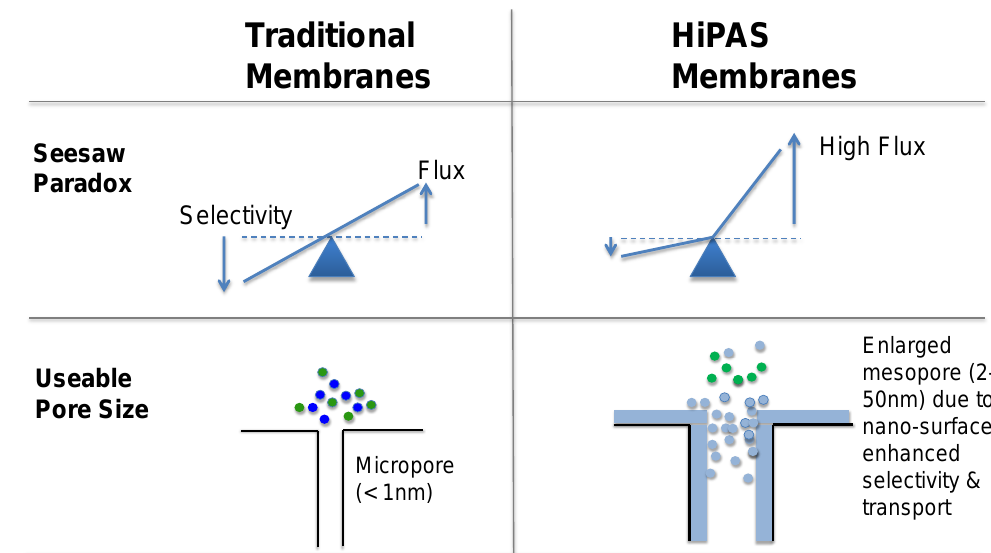
Figure 1. Schematic illustrating the pore size and surface difference between traditional membranes and HiPAS membranes. The HiPAS membranes are designed to take full advantage of the membrane surface superhydrophilicity or superhydrophobicity with relatively larger pores (>a few nanometers to tens of nanometers), to enhance permeation flux with the least loss of selectivity.